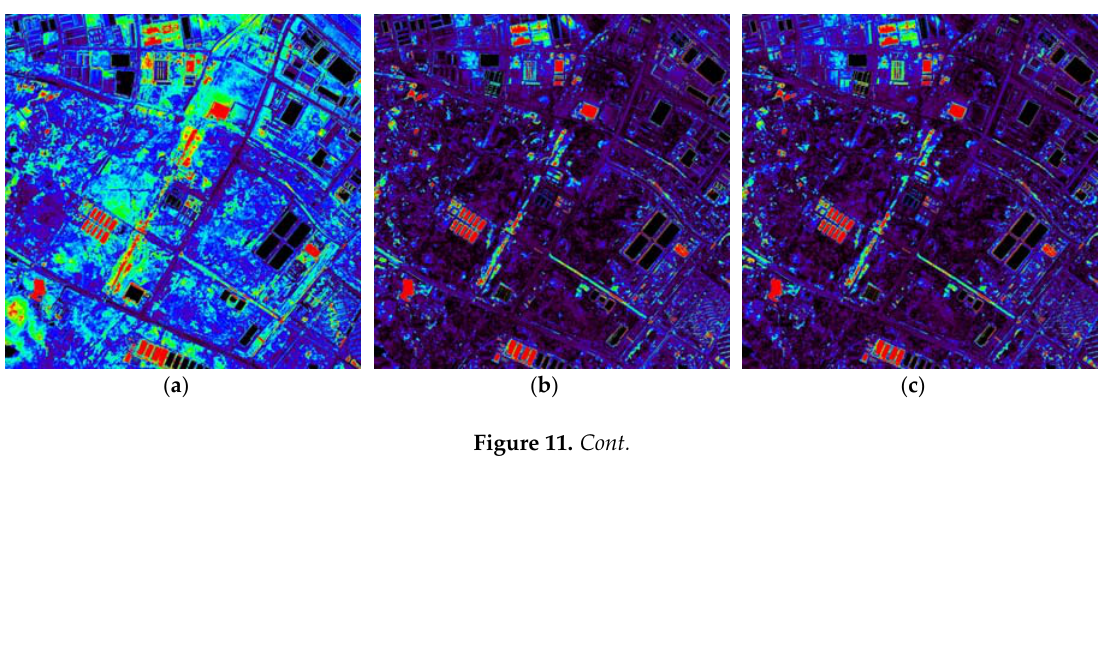
Figure 10. The reference map where red indicates change and green indicates nonchange.